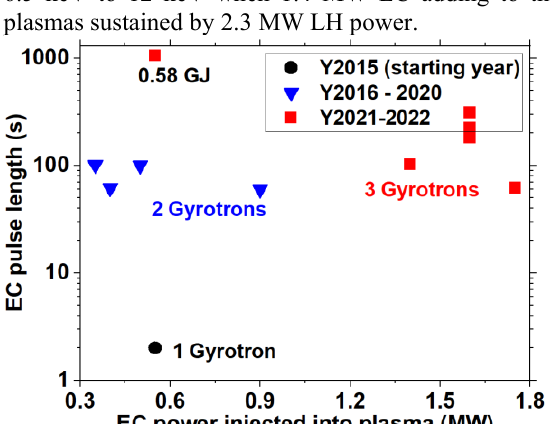
Fig. 2. Advances in the EC power injected into plasma and in their pulse duration on EAST. Fig. 5. The increment of plasma stored energy and central electron temperature after EC power injection versus EC power deposition location. Shaping of the current density profiles by adjusting the EC power deposition is demonstrated. As shown in Fig. 6, when the EC power shifts from  ~ 0.03 to 0.3, the internal inductance ( l i ) is decreased by ~ 0.3, indicating an off-axis ECRH is helpful to broaden the current profile. The power density profiles calculated by TORAY code are plotted in Fig. 7. This conclusion is further verified by the polarimeter /interferometer (POINT) measurement [8, 9] as illustrated in Fig. 8. The Faraday rotation angle is propotional to ∫𝑛 e (𝑧) 𝐵 || (𝑧)𝑑𝑧 , where B || is the magnetic field component along the laser beam and d z is the plasma path length. Since